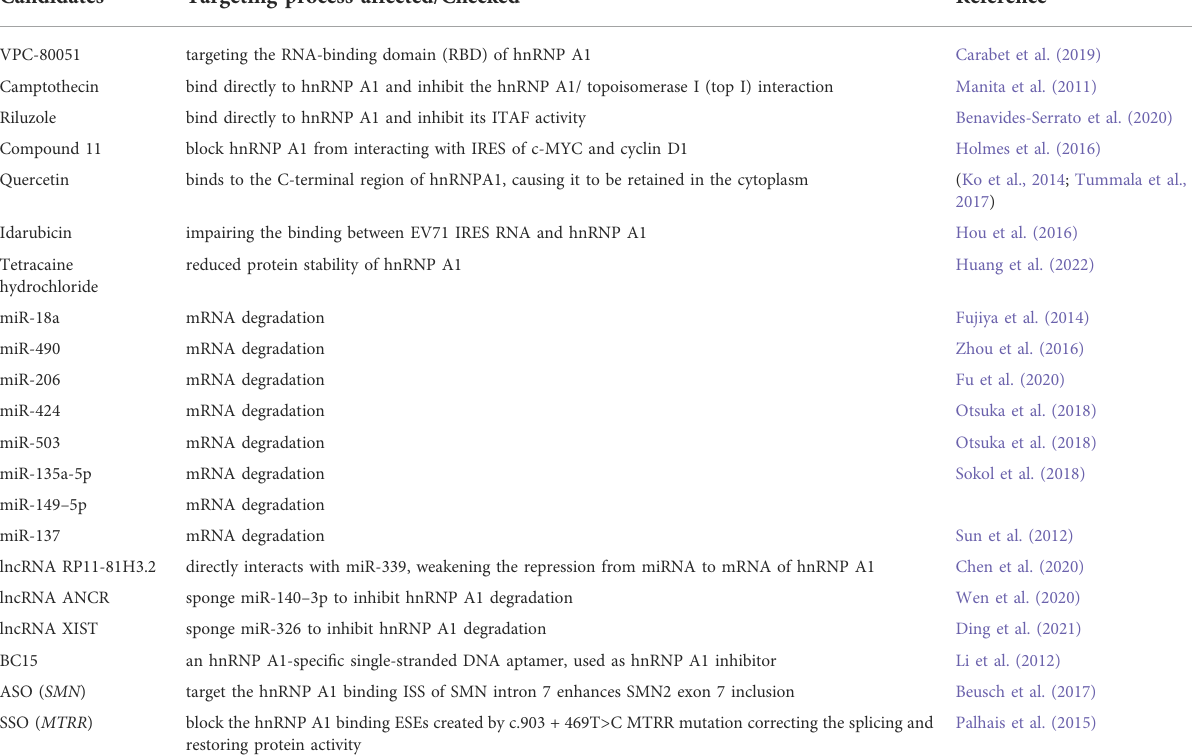
TABLE 4 Available Approaches Targeting hnRNP